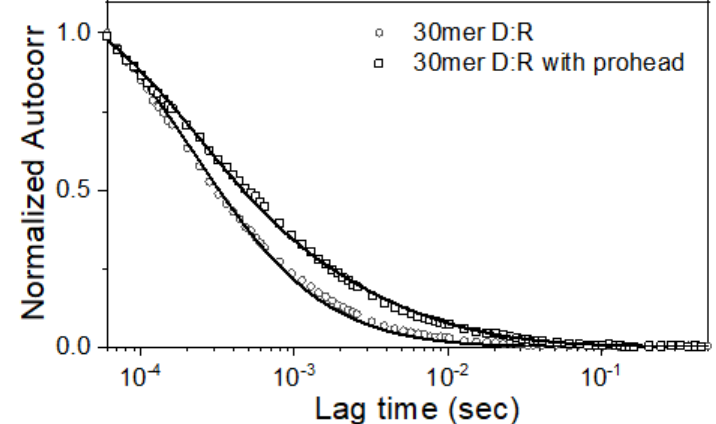
Figure 4. Autocorrelation plots of fluorescently labeled 30 mer D:R construct in the presence and absence of prohead. Experimental data are shown as points, and curves fitted with a one (30mer D:R) or two (30 mer D:R plus prohead) species diffusion model are superimposed as lines.